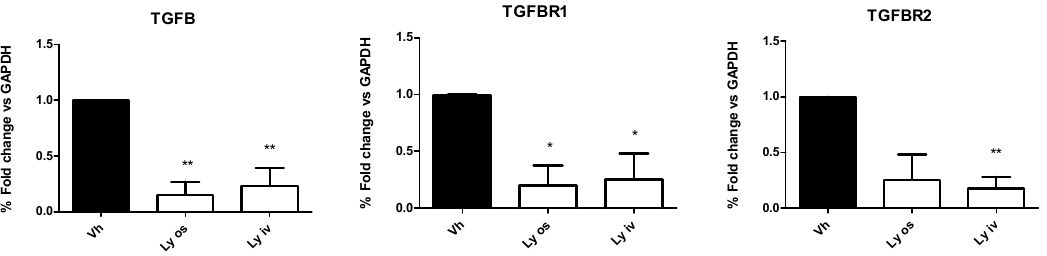
Figure 5. mRNA expression of TGF- β 1, TGF- β RI and TGF- β RII investigated by qRT-PCR was significantly down-regulated (* p < 0.05; ** p < 0.01) in mice treated either orally with nanoparticle encapsulated Galunisertib (Ly os) or intravenously with the Galunisertib solution (Ly iv) as compared to controls (Vh).